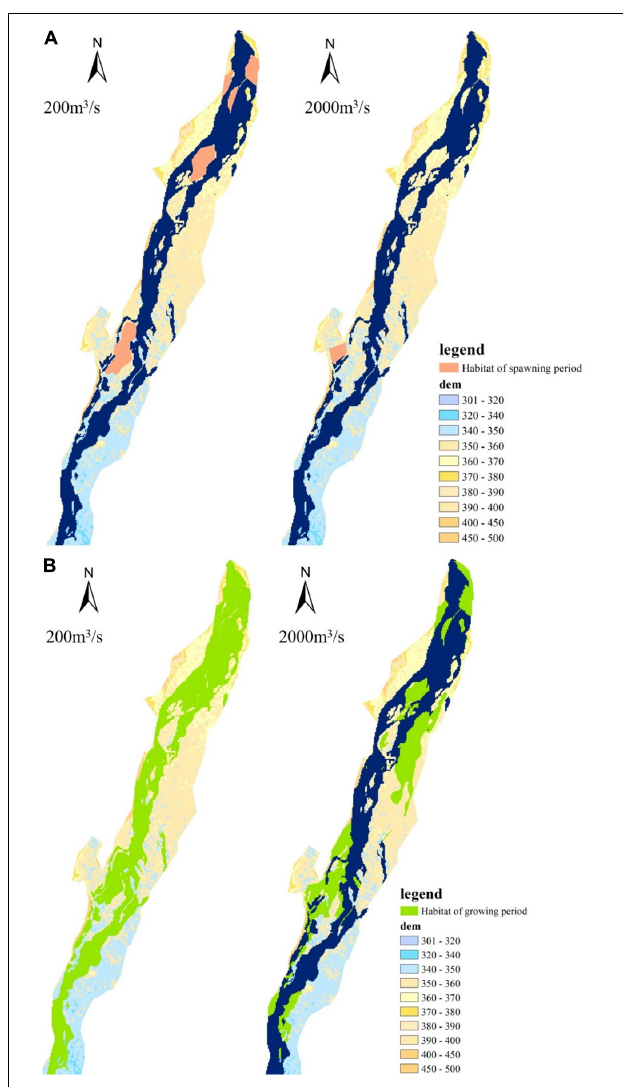
FIGURE 7 | The habitat distribution of Cyprinus carpio at different stages under different flows of LM. (A) Habitat distribution in spawning period. (B) Habitat distribution in growing